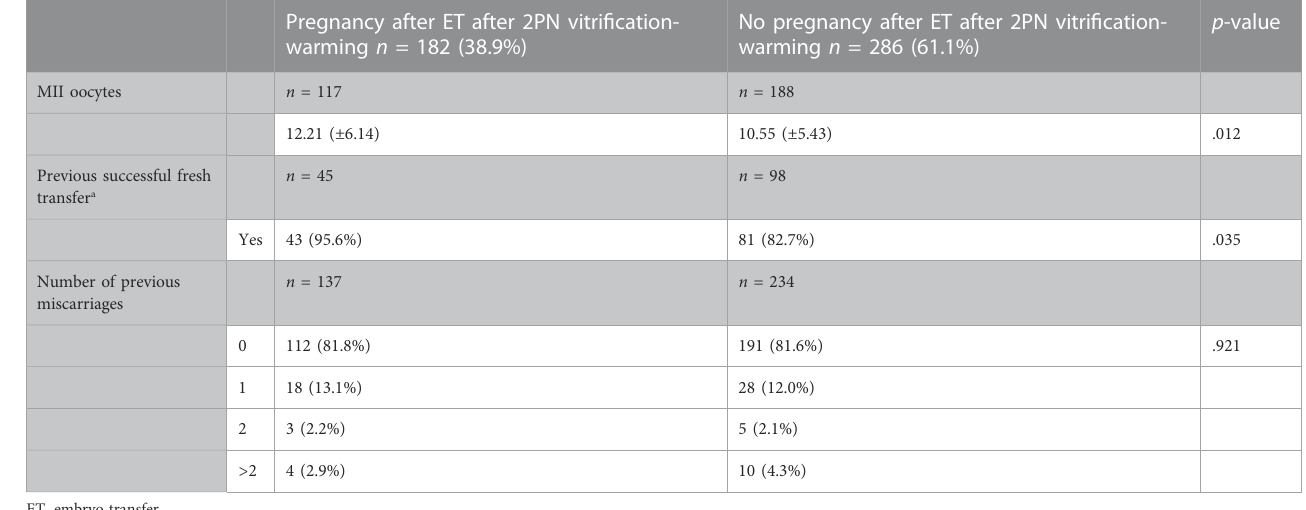
TABLE 4 Results of fertility treatment. Pregnancy after ET after 2PN vitri fi cation- warming n = 182